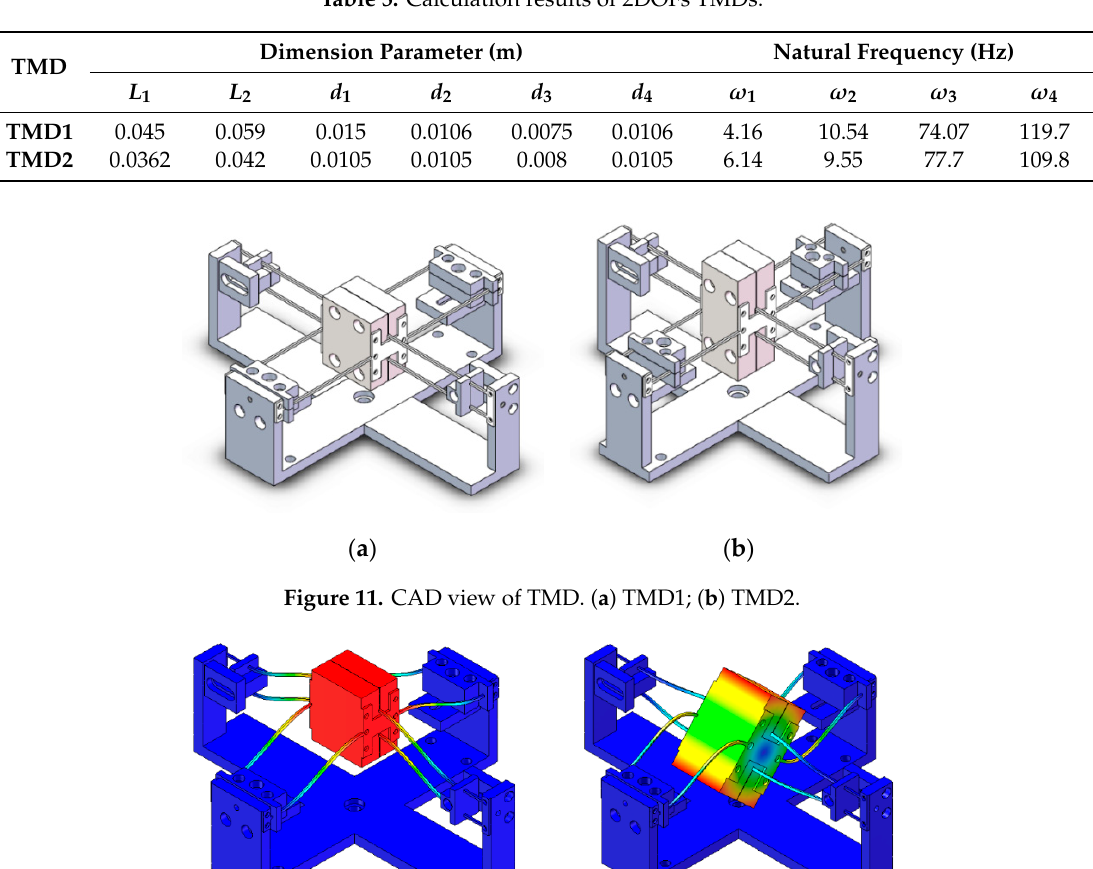
Table 4. Expected modes of 2DOFs TMDs.